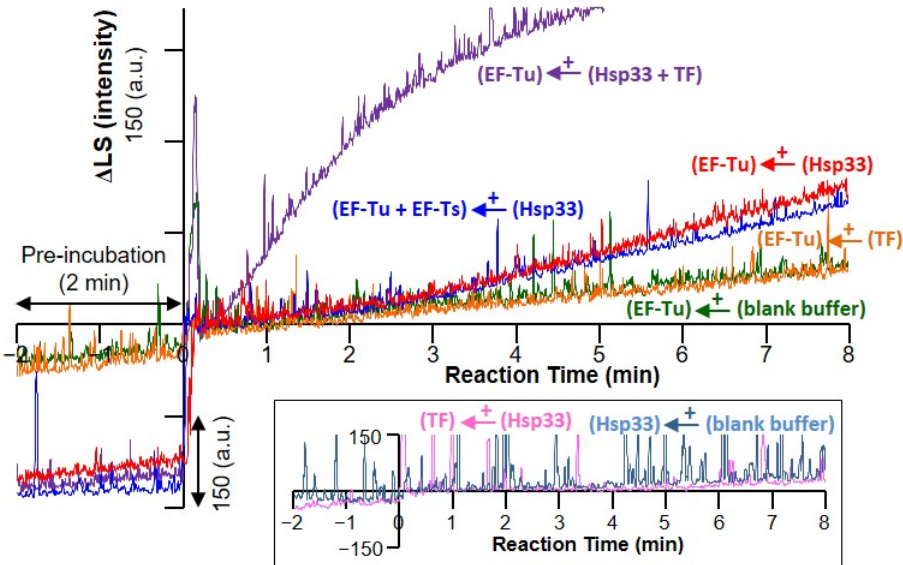
Figure 2. Aggregation of EF ‐ Tu detected via light scattering. Light scattering intensity (arbitrary unit, a.u.) at 400 nm was recorded for 10 min, including the pre ‐ incubation (2 min) and reaction monitoring (8 min) periods. Time ‐ course change of the light scattering intensity ( Δ LS) is shown for indicated protein samples. EF ‐ Tu (green, red, purple, and orange) and EF ‐ Tu:EF ‐ Ts complex (blue) were incubated at 35 ° C, followed by equimolar (15 μ M) titration (designated as the time 0 min) of Hsp33 (red and blue), TF (orange), or both (purple). Control experiments for EF ‐ Tu alone (green) and Hsp33 alone (light blue in the inset) were performed by adding blank buffer, whereas TF alone is presented in the pre ‐ incubation period for subsequent addition of Hsp33 (pink in the inset).